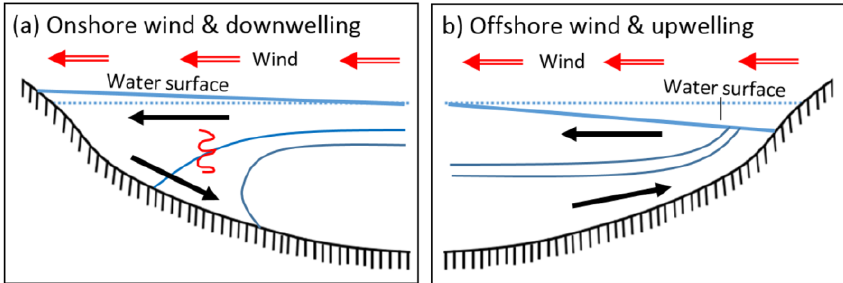
Figure 2. Schematic of the overturning circulation in shallow water, defined by (1), for ( a ) onshore